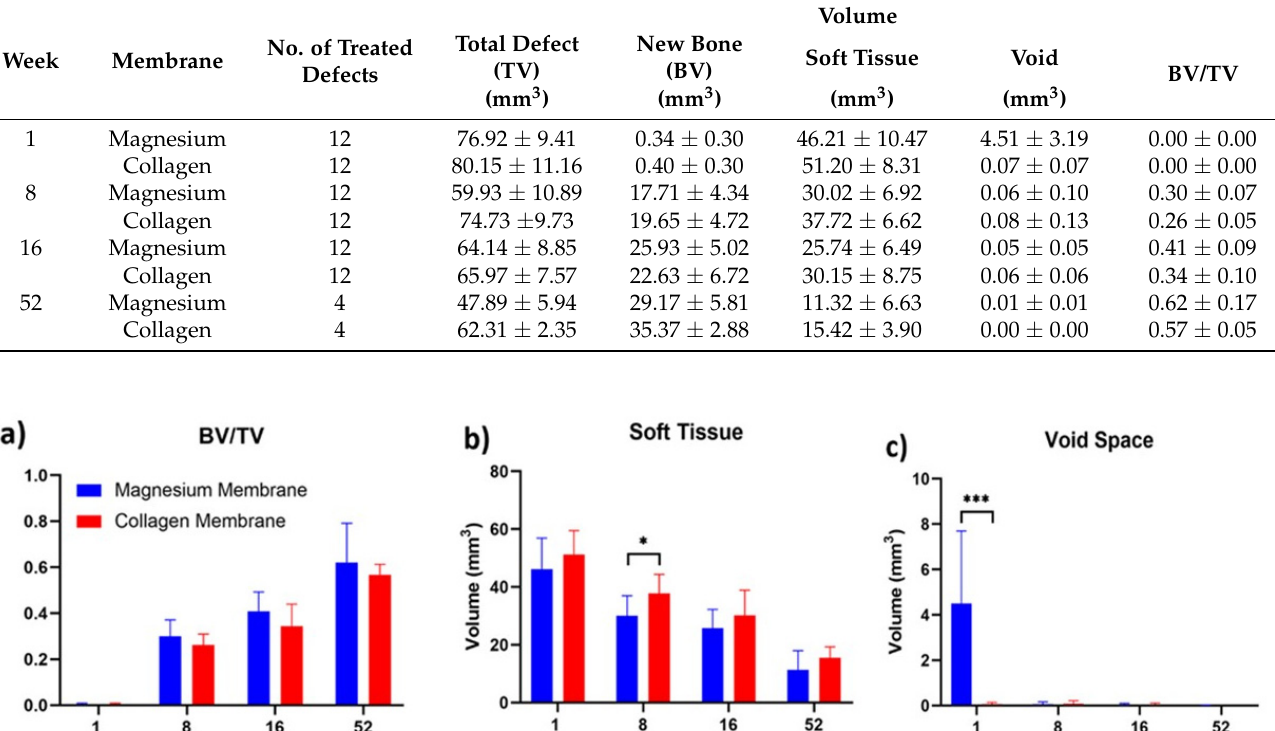
Table 1. µ CT volume measurements for GBR defects treated with either a magnesium membrane or collagen membrane.